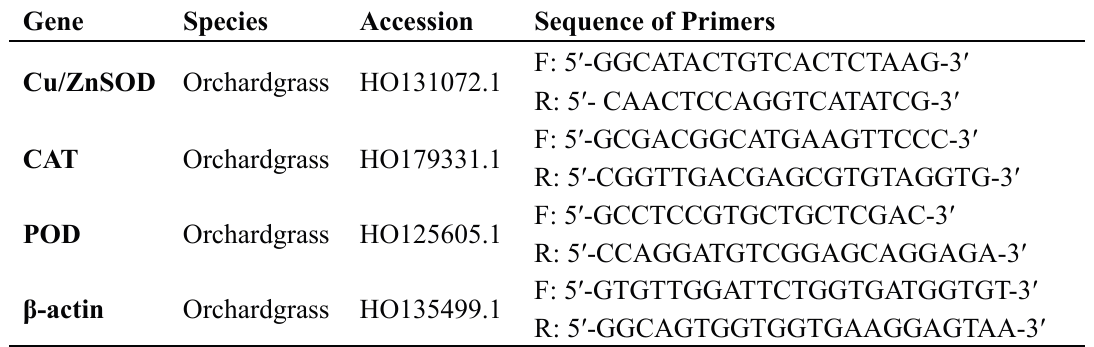
Table 1. The primer sequences for real-time qPCR analysis of Cu/ZnSOD, POD, CAT and β -actin